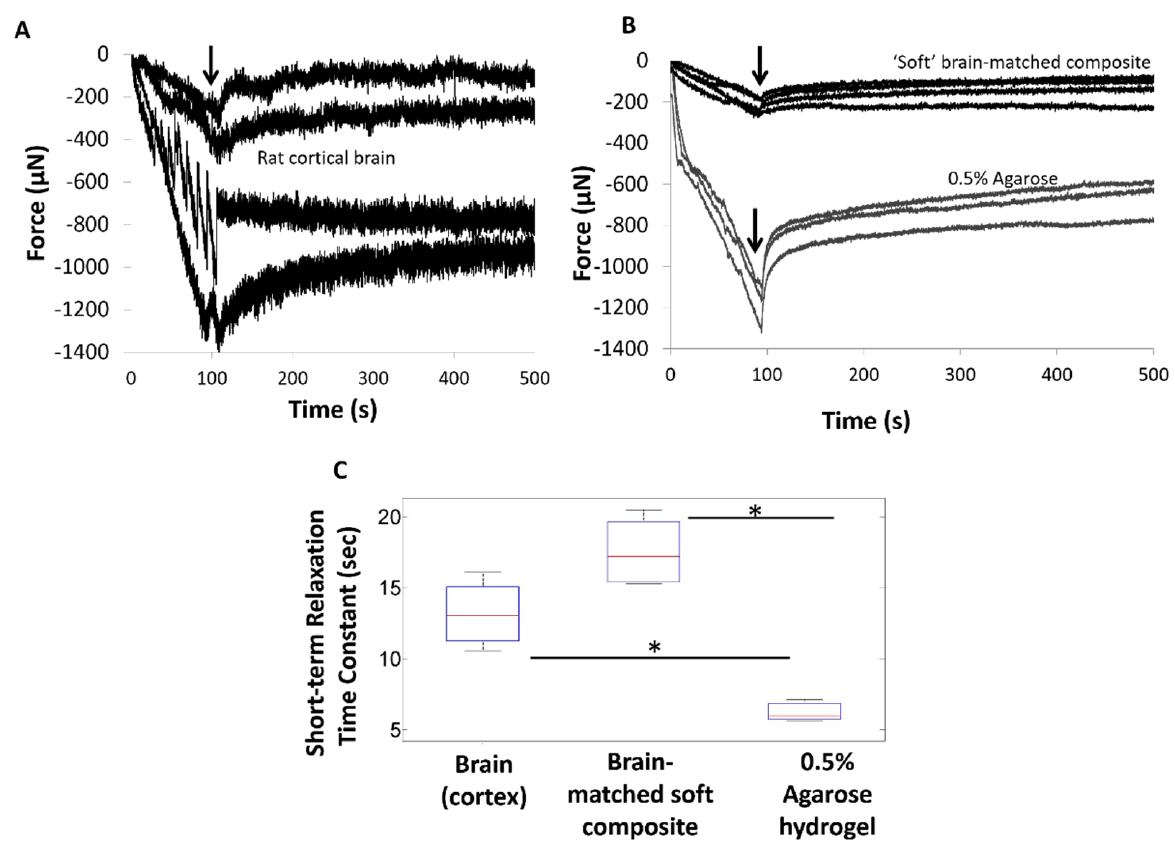
Figure 2. Typical force curves using a conical stainless steel probe in ( A ) rat cortical brain in vivo (data from [25]), ( B ) brain-like silicone/CNT composite and 0.5% agarose phantoms. Arrows indicate stoppage of probe movement with subsequent relaxation of brain tissue. ( C ) The short-term time constant of viscoelastic, relaxation phase of the force curves was determined using a second order Prony series model. Significant differences after correction by Bonferroni factor (* p < 0.016) in the short-term relaxation time constant were shown between in vivo brain, silicone/CNT composite and agarose hydrogel.